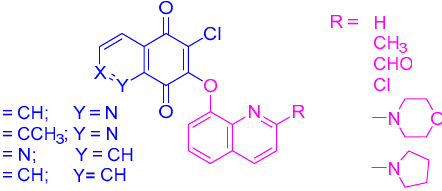
Figure 1. The chemical structure of quinoline-1,4-quinone hybrids.